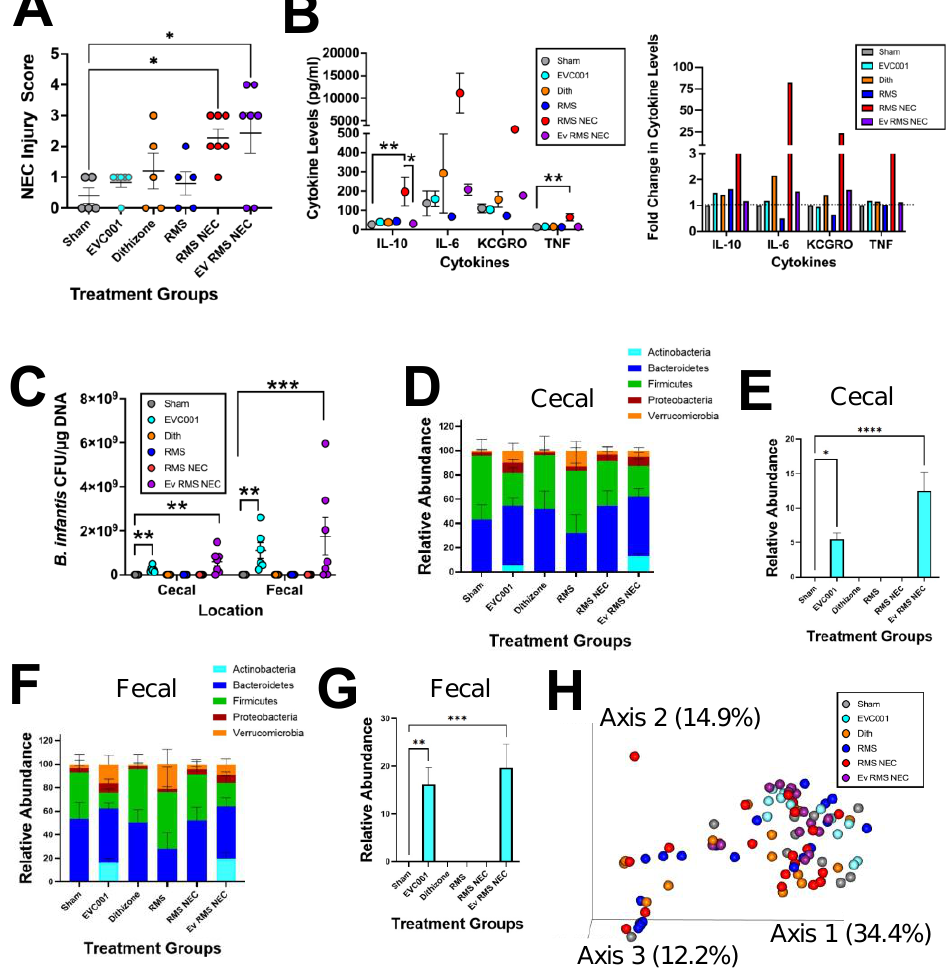
Figure 4. EVC001 efficacy in decreasing experimental NEC injury is model dependent. ( A ) NEC injury scores for control mice, RMS formula NEC mice, and RMS formula NEC mice receiving EVC001 (Ev RMS NEC) ( n ≥ 5 mice per group) ( B ) Serum cytokine levels for IL-10, IL-6, KC-GRO, and TNF and the representative fold changes ( C ) Quantitative PCR probing for B. infantis EVC001 DNA within the cecal and fecal microbiome ( n ≥ 5 mice per group) ( D ) Phylum level relative abundances for the cecal microbiome ( n ≥ 5 mice per group) ( E ) Bifidobacteriaceae family level relative abundances for the cecal microbiome ( n ≥ 5 mice per group) ( F ) Phylum level relative abundances for the fecal microbiome (colon contents) ( n ≥ 5 mice per group) ( G ) Bifidobacteriaceae family level relative abundances for the fecal microbiome ( n ≥ 5 mice per group) ( H ) Weighted UniFrac principal coordinate analysis plot including cecal and fecal samples within each group ( n ≥ 5 mice per group) . For all p values, * ≤ 0.05, ** * ≤ 0.01, *** ≤ 0.001, and **** ≤ 0.0001.